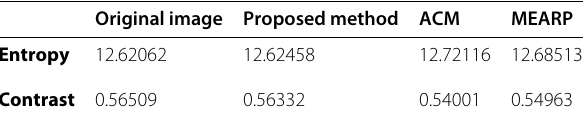
Table 2 Comparison of simulated imaging results under a